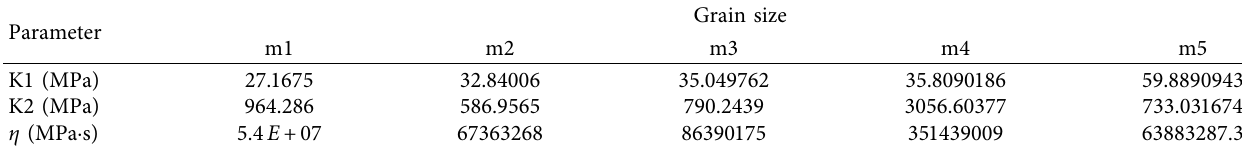
Table 3: Kelvin–Voigt model parameter table of fragmentized coals with different grain sizes under the stress of 12MPa.